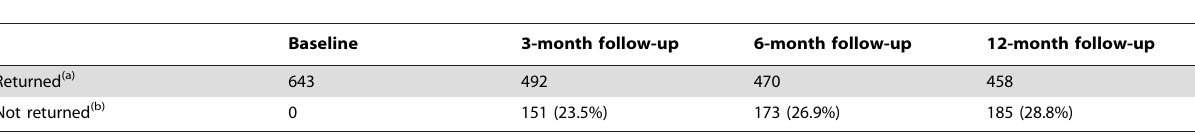
Table 2. Questionnaire return and non-return at each follow-up